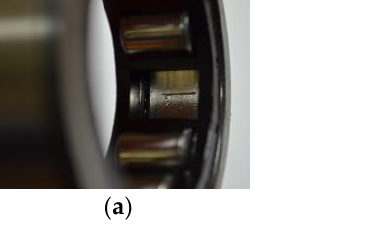
Figure 9. The seeded bearing faults: (a) outer race way with a crack on its surface (ORCS); (b) inner race way with a crack on its surface (IRCS); and (c) rolling element with a crack on its surface (RECS).